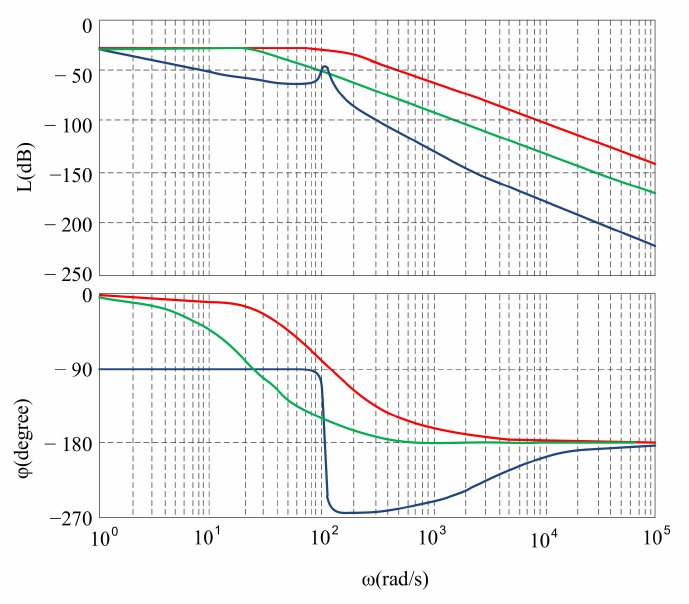
Figure 12. Bode diagrams of: __ open system; __ closed system by ω 0 = 25; __ closed system by ω 0 =